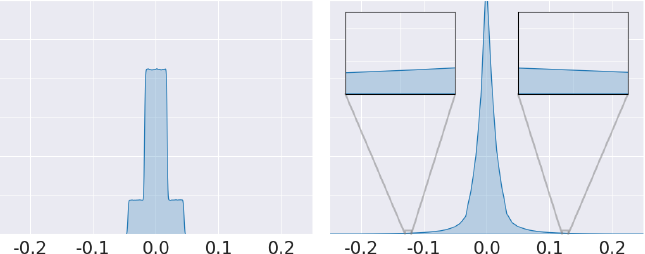
Figure 10. Weight histogram of an MLP before teleportation ( left ) and after teleportation ( right ) with CoB-range of 0.9. Initialization is the standard on PyTorch which is uniform and contains values between 0.05 and 0.05 while the teleported weights are more broadly distributed as shown in − the zooms.